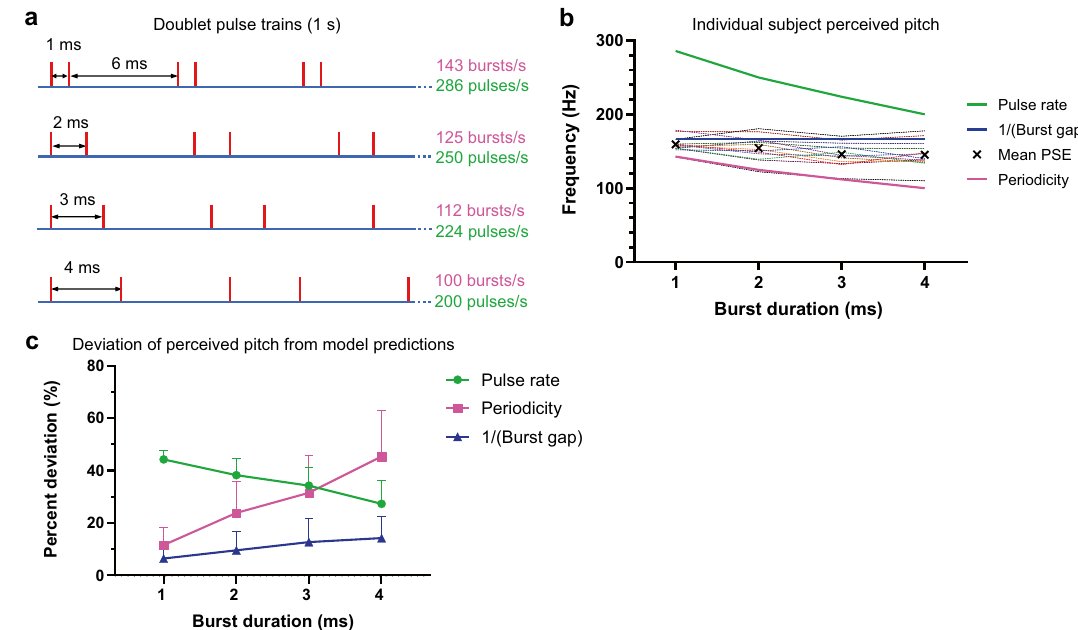
Figure 4. Pitch perception at 6 ms inter-burst interval. ( a ) Schematic representation of doublet trains with varying burst duration but consistent inter-burst interval (6 ms). ( b ) PSE values obtained in psychophysical tests. Dashed lines represent individual subjects’ PSEs (n = 13), solid lines indicate predicted PSEs if pitch judgements were based on pulse rate (green), the inverse of the inter-burst interval/burst gap (blue), and periodicity (pink). ( c ) Deviation of subjects’ PSEs (n = 13) for each test stimulus from its rate, periodicity and burst gap predicted values, expressed as a percentage of the predicted value. Each data point represents mean and